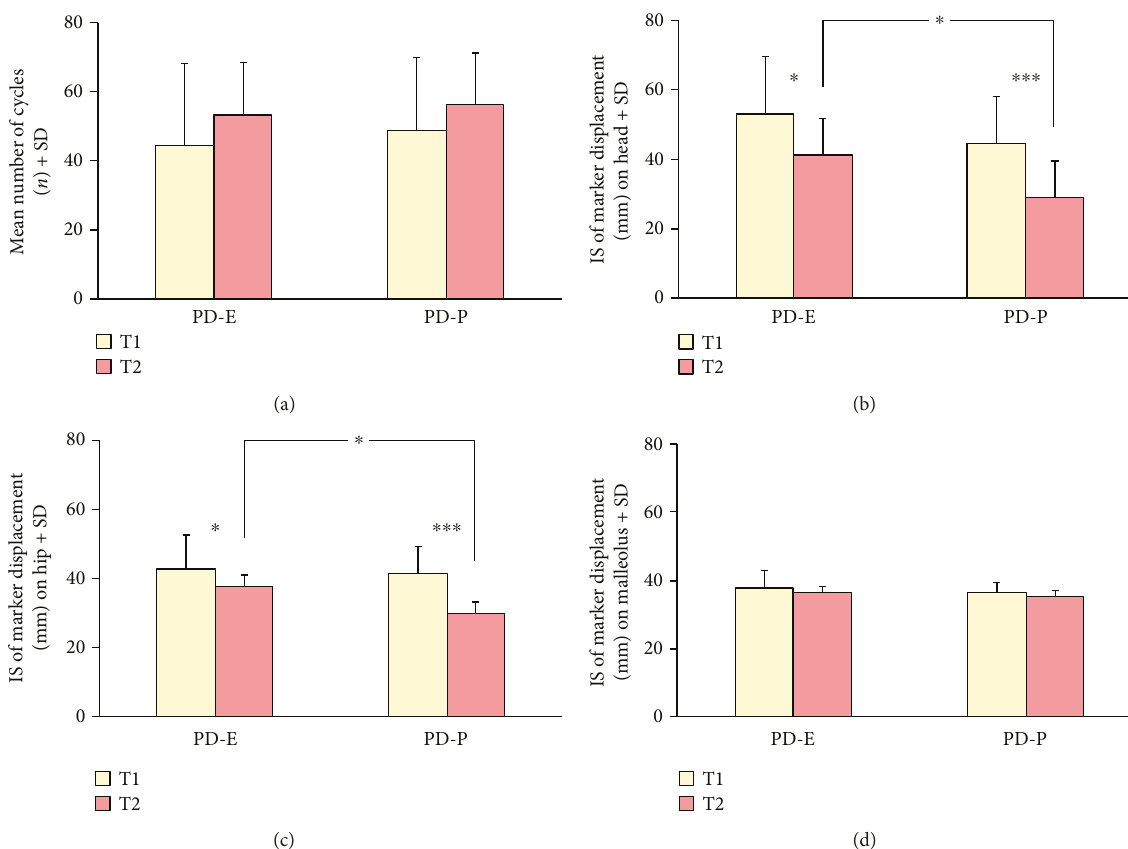
Figure 3: Training e ff ects on body stabilization assessed by the moving-platform test in the two groups of patients (PD-E and PD-P) at baseline (T1, yellow columns) and after treatment (T2, pink columns). All subjects were tested at 0.4Hz perturbation frequency, eyes closed. At T2, patients endured longer periods on the platform than at T1 (a). Head (b) and hip (c) displacement (Index of Stability (IS)) improved signi fi cantly after both platform and exercise training, indicating a decrease in body segment oscillation. IS at T2 was better in the PD-P than in the PE-E group for both the head and hip. (d) shows that feet position on the platform was substantially unvarying for patients in both groups. Asterisks ( ∗ p < 0 05 ; ∗∗∗ p < 0 0005 ) indicate di ff erences (T1, T2) within groups and between groups at T2.